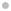
BAP is bacteriostatic.E. coli cultures at an initial inoculum density of 106 CFU/mL in M9-glucose were incubated in the presence of BAP (●) at 4 × MIC (80 μM, or 15 μg/mL), compared to control in the absence of BAP (■) in biological triplicate. Enumeration of bacteria on agar plates over time (0, 2, 4, 6, and 20 h) indicates that BAP is bacteriostatic. (n = 3, error bars represent standard error).